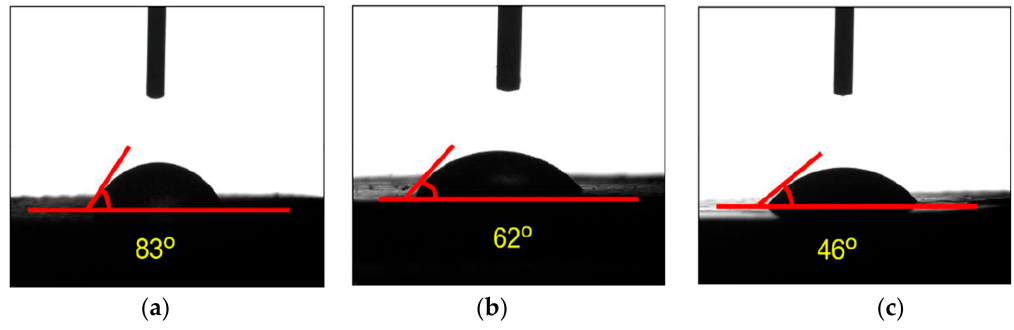
Figure 6. Contact angle studies comparing ( a ) raw SRL; ( b ) physical mixtures; and ( c ) SRL nanoparticle.